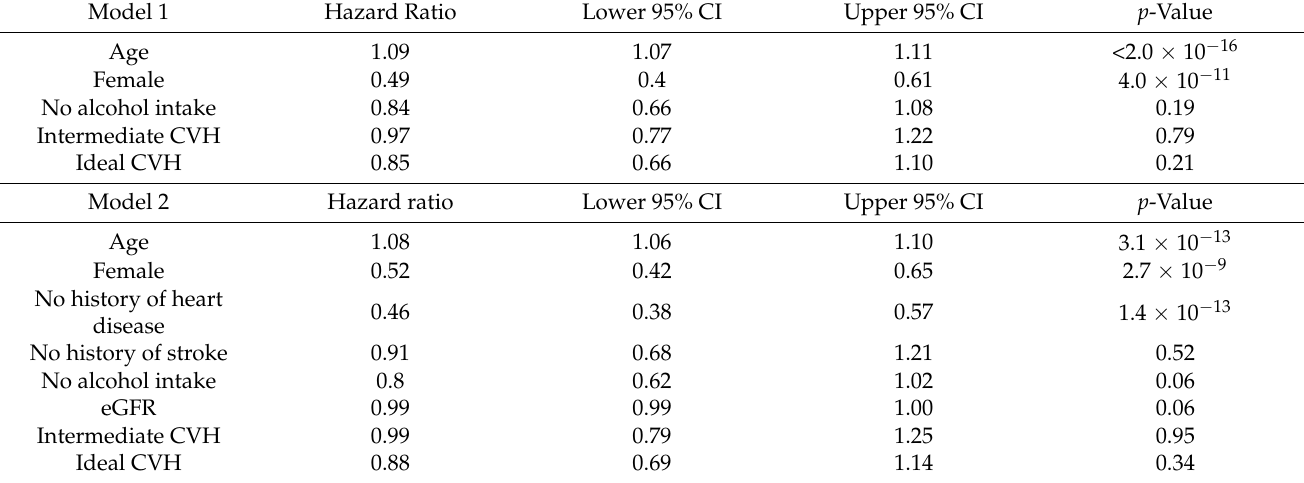
Table 4. Association between cardiovascular health (CVH) score and incident atrial fibrillation in younger participants ( ≥ 75 years). Model 1 was adjusted for age, gender, and regular alcohol intake. Model 2 was adjusted for age, gender, history of heart disease, history of stroke, regular alcohol intake, and estimated glomerular filtration rate. The hazard ratio of the intermediate and ideal CVH groups was calculated using the poor CVH group as a